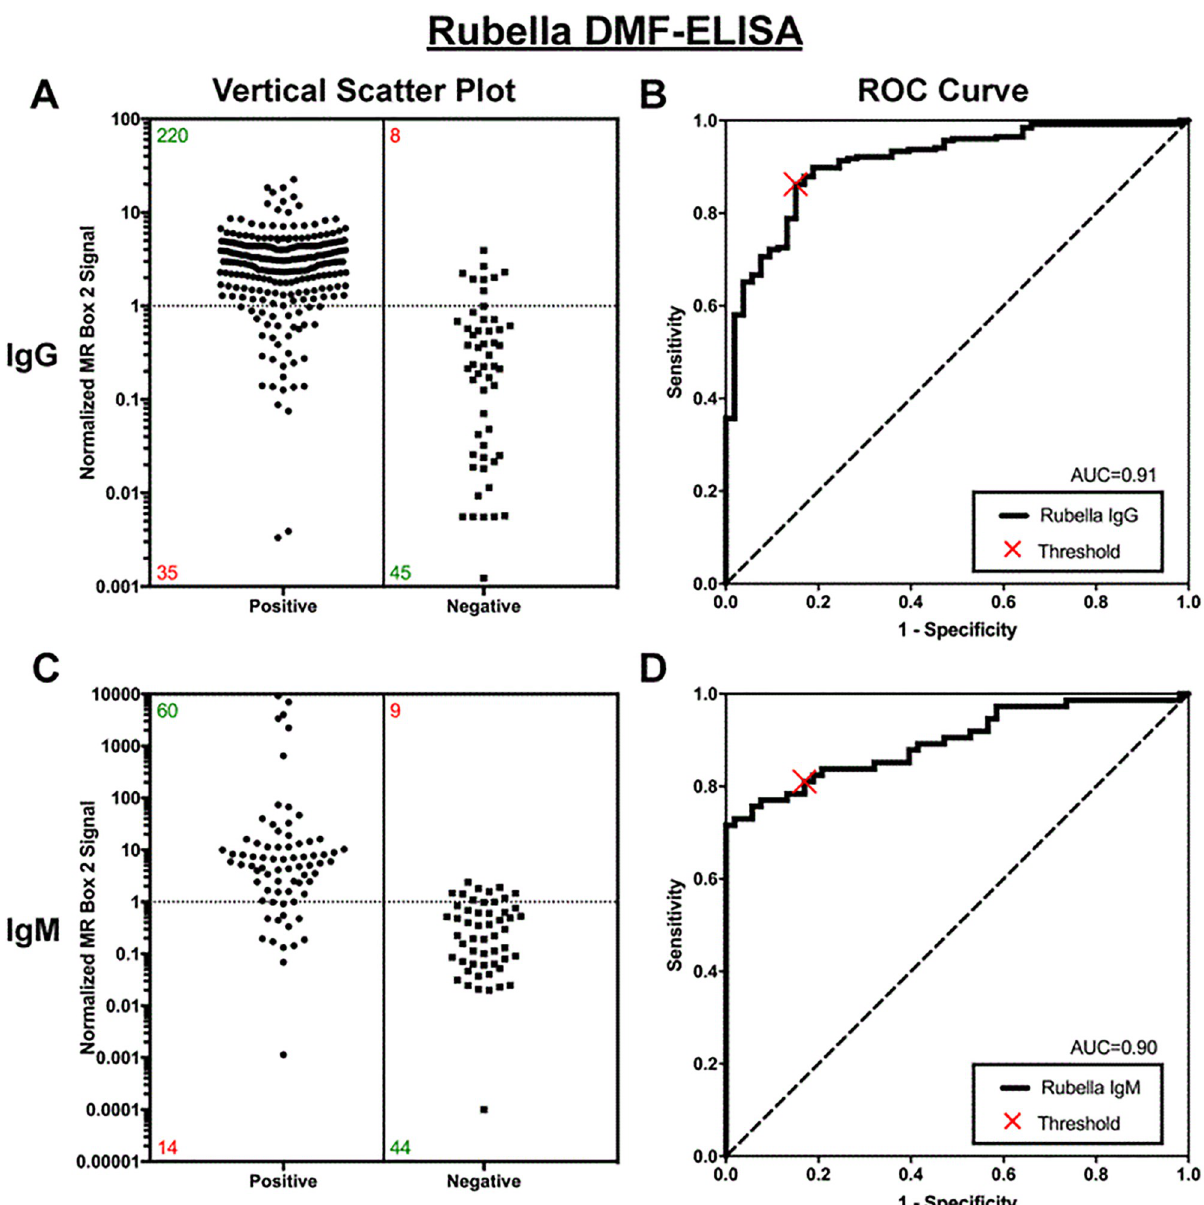
Fig 3. Performance of DMF-ELISA for assessing 308 specimens for rubella IgG (A and B) and 127 specimens for rubella IgM (C and D) compared with a reference ELISA. Vertical scatterplot (left) of MR Box 2 signals for specimens determined to be positive or negative for anti-rubella IgG (top, n = 308) and IgM (bottom, n = 127) by reference tests. Green and red numbers in the scatterplot represent the number of specimens correctly and incorrectly categorized by the MR Box 2, respectively. (B and D) Receiver Operating Characteristic (ROC) curves with an optimized threshold